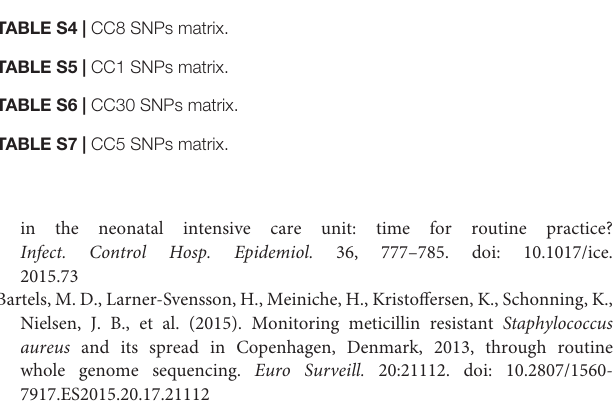
TABLE S1 | Strain data. TABLE S2 | Data analysis parameters set. TABLE S3 | Genome list used for the pangenome construction (complete circular assembly). TABLE S4 | CC8 SNPs matrix. TABLE S5 | CC1 SNPs matrix. TABLE S6 | CC30 SNPs matrix. TABLE S7 | CC5 SNPs